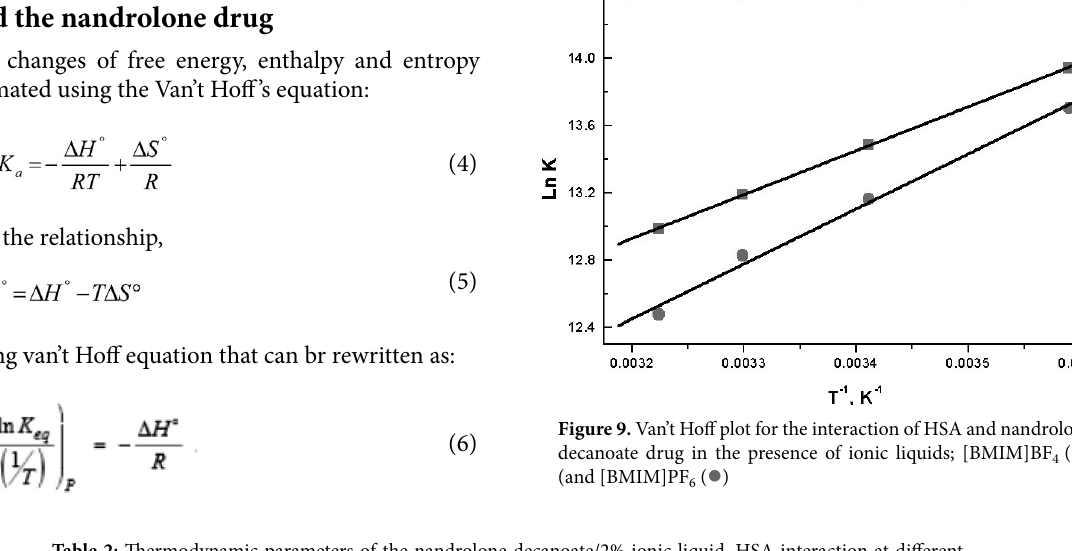
Table 2: Thermodynamic parameters of the nandrolone decanoate/2% ionic liquid–HSA interaction at different temperatures and pH 7.0.